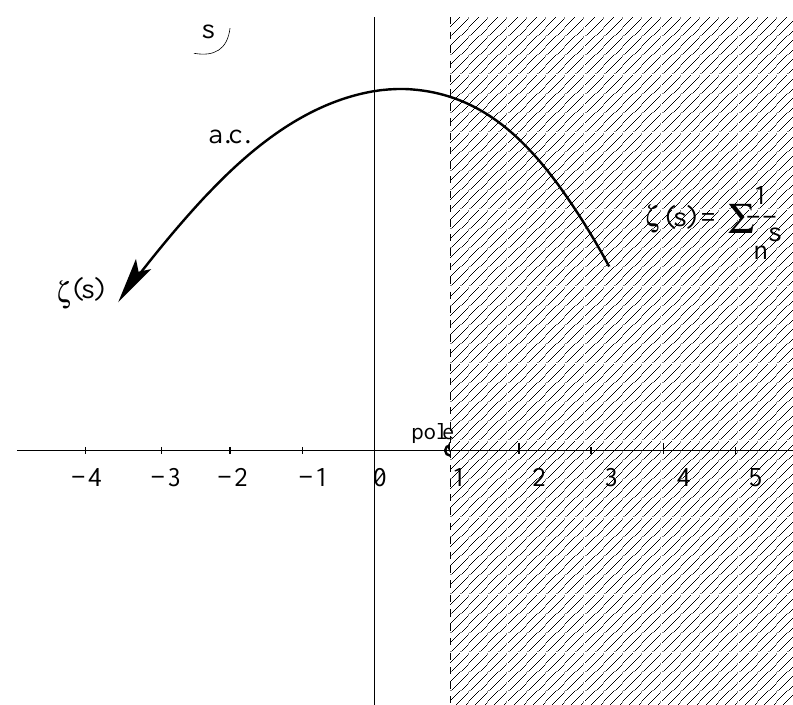
Figure 1. This is a scheme of the construction of the zeta function ζ ( s ) on the complex plane, s ∈ C . The function is defined as follows. On the open half of it which lies on the rhs of the abscissa of convergence, Re s = 1, the function ζ is given by the original, absolutely convergent series: ζ ( s ) = ∑ ∞ n = 1 n − s . On the left side of the plane, ζ ( s ) is given by the analytic continuation of this series, which is known to be uniquely defined and meromorphic. Namely, it is analytic on the whole complex plane, with the only exception of a simple pole, with residue 1, at s = 1. At this point the logarithmically divergence of the original harmonic series shows